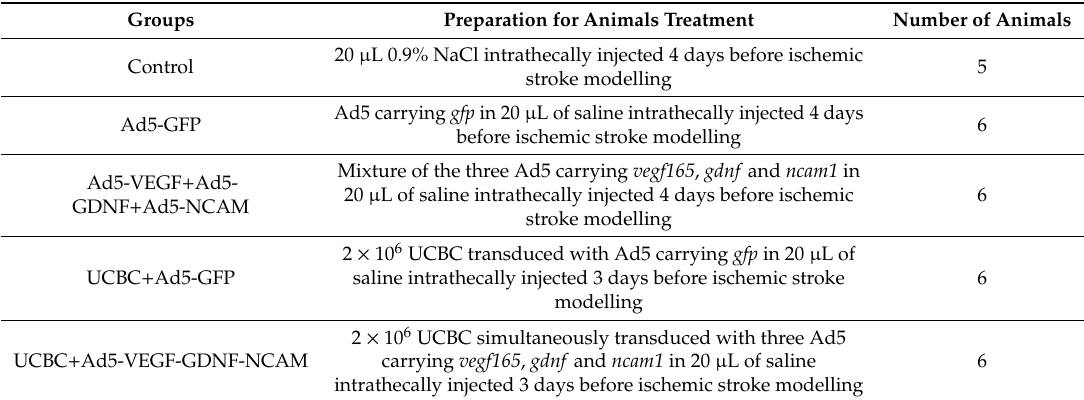
Table 1. Experimental groups of